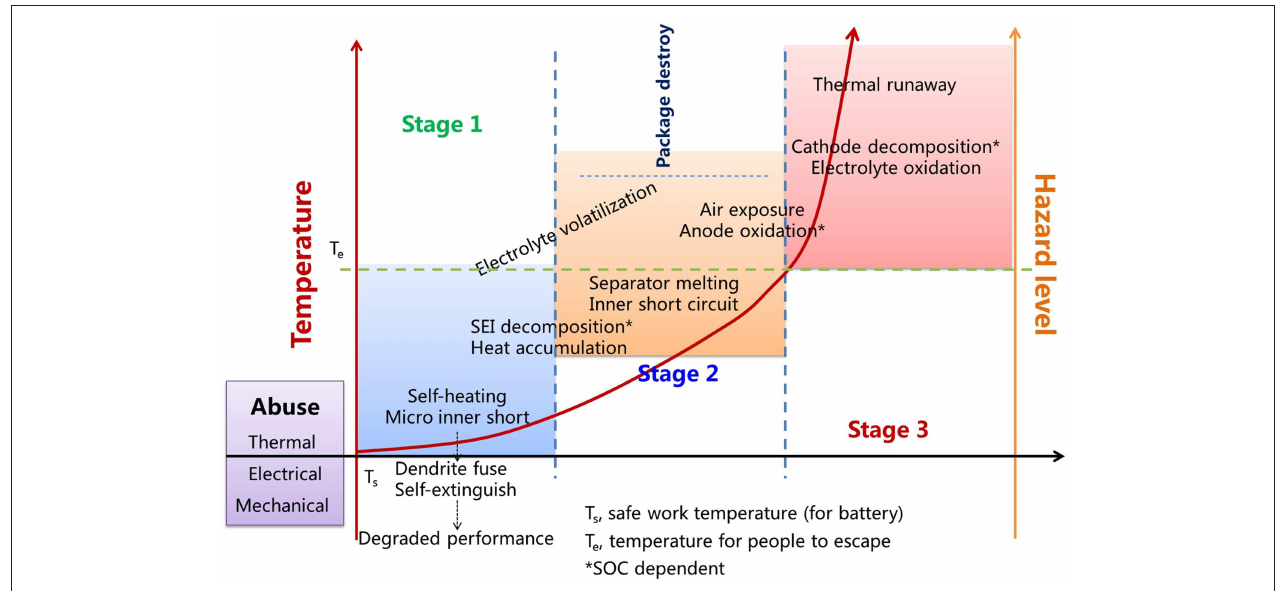
FIGURE 1 | Three stages in battery TR, T s , safe work temperature (for battery); T e , temperature for people to escape; * SOC